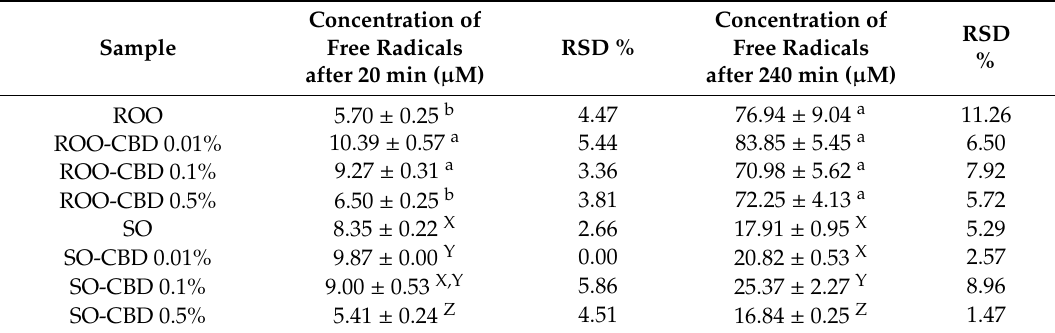
ROO = refined olive oil. ROO-CBD = refined olive oil with CBD, the percentage indicates the CBD / oil ratio. SO = sunflower oil. SO-CBD = sunflower oil with CBD, the percentage indicates the CBD / oil ratio. Di ff erent letters indicate statistically significant di ff erences (Anova, Fisher’s test LSD, p <